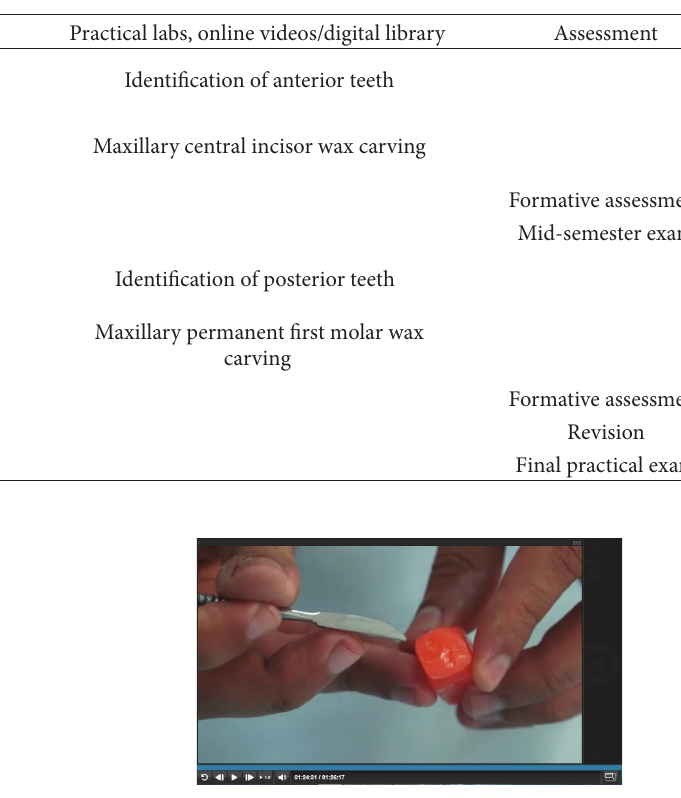
Figure 2: An example of the online videos developed as part of the flipped classroom method used in this